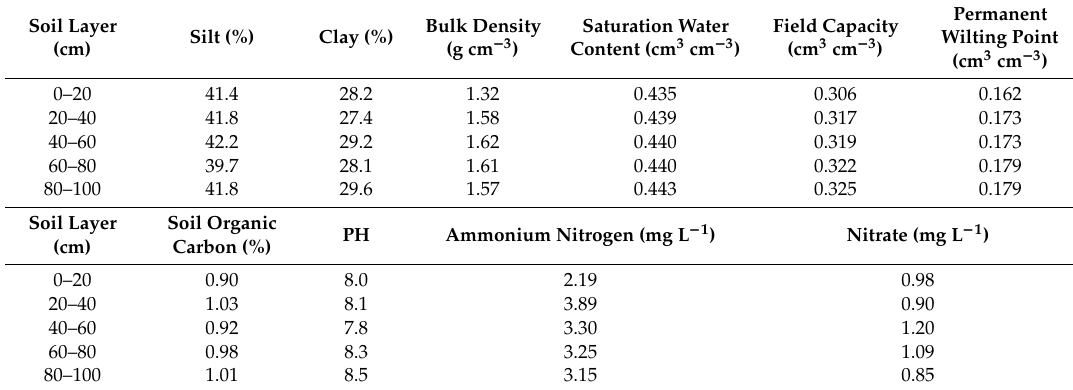
Table 1. Soil characteristic parameters in the study site.